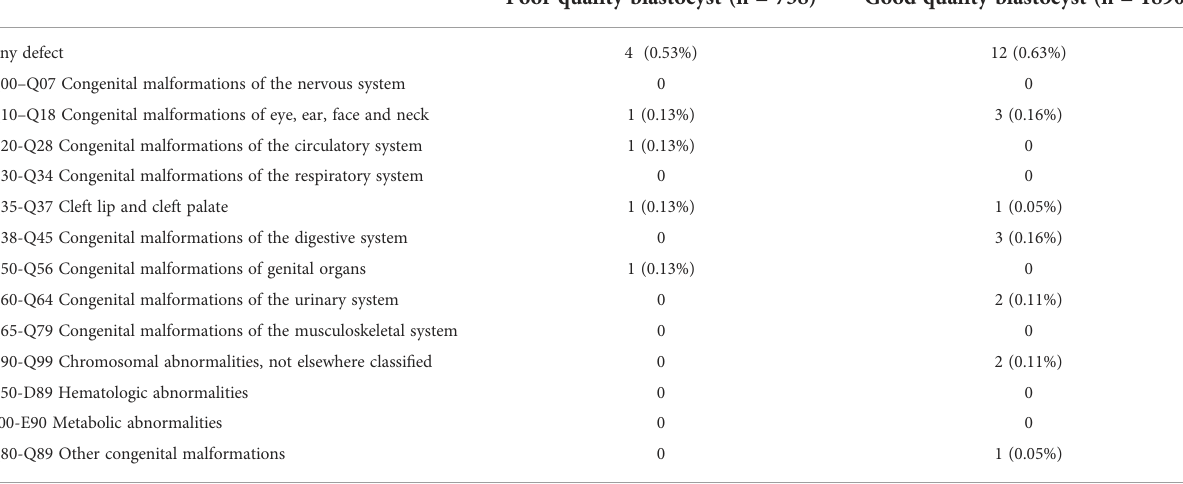
TABLE 5 Distribution of birth defects in live-born singletons according to quality of blastocyst transferred.